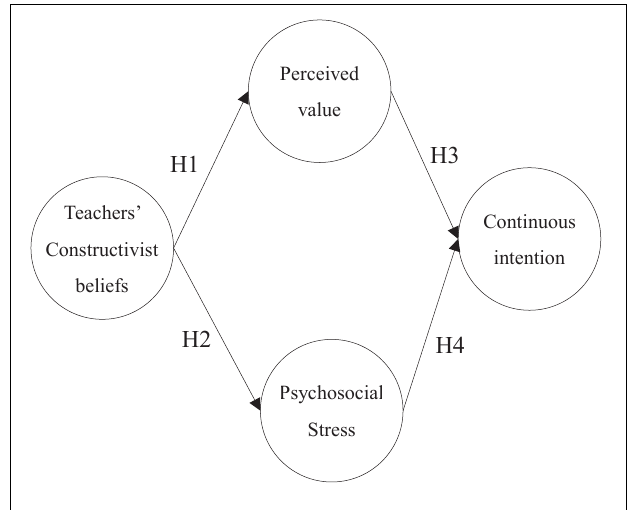
FIGURE 1 | Research